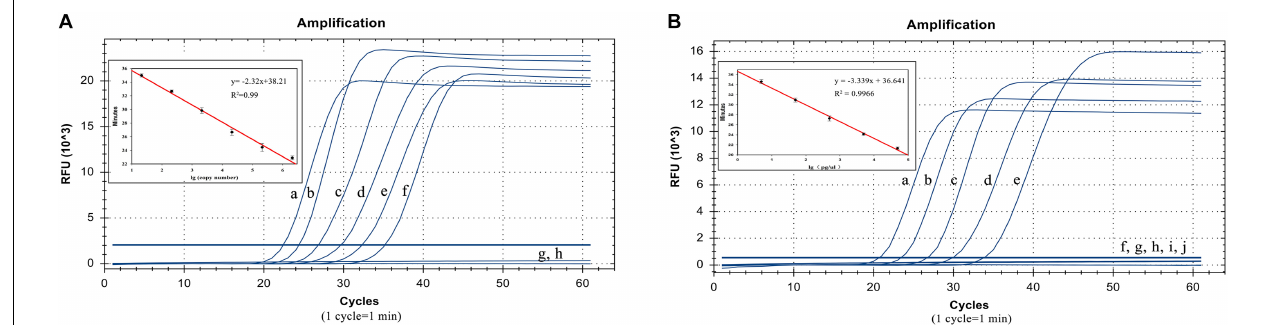
FIGURE 4 | Detection limit test results. (A) LP-LAMP method for the detection of plasmid concentrations. Diluted Salmonella Pullorum plasmid was used at the following concentrations: (a) 2.1 × 10 6 copies/ µ L, (b) 2.1 × 10 5 copies/ µ L, (c) 2.1 × 10 4 copies/ µ L, (d) 2100 copies/ µ L, (e) 210 copies/ µ L, (f) 21 copies/ µ L, (g) 2.1 copies/ µ L. (h) Negative control. (B) LP-LAMP method for the detection of genomic DNA, diluted Salmonella Pullorum genomic DNA was used at the following concentrations: (a) 49.2 ng/ µ L, (b) 4.92 ng/ µ L, (c) 492 pg/ µ L, (d) 49.2 pg/ µ L, (e) 4.92 pg/ µ L, (f) 492 fg/ µ L, (g) 49.2 fg/ µ L, (h) 4.92 fg/ µ L, (i) 0.49 2fg/ µ L, (j) Negative control.